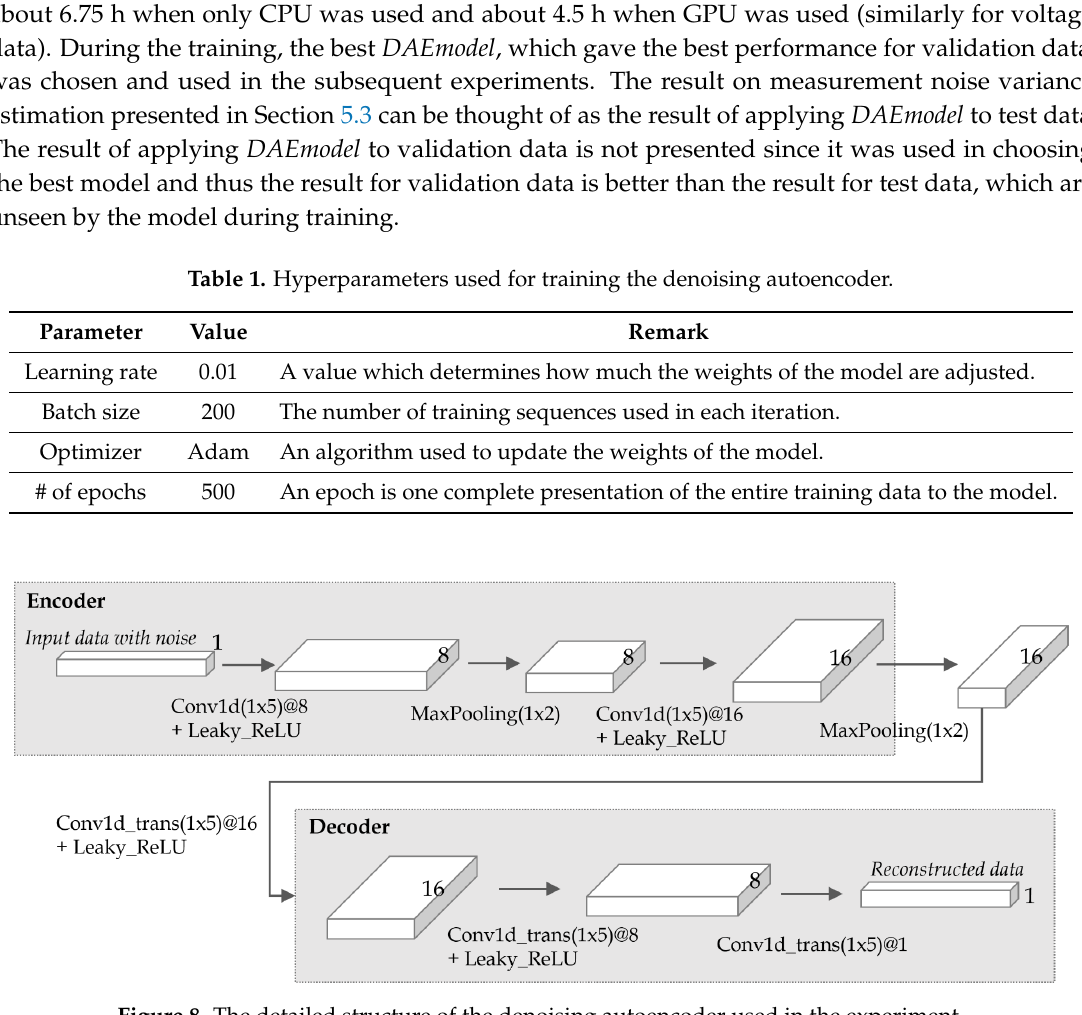
Figure 8. The detailed structure of the denoising autoencoder used in the